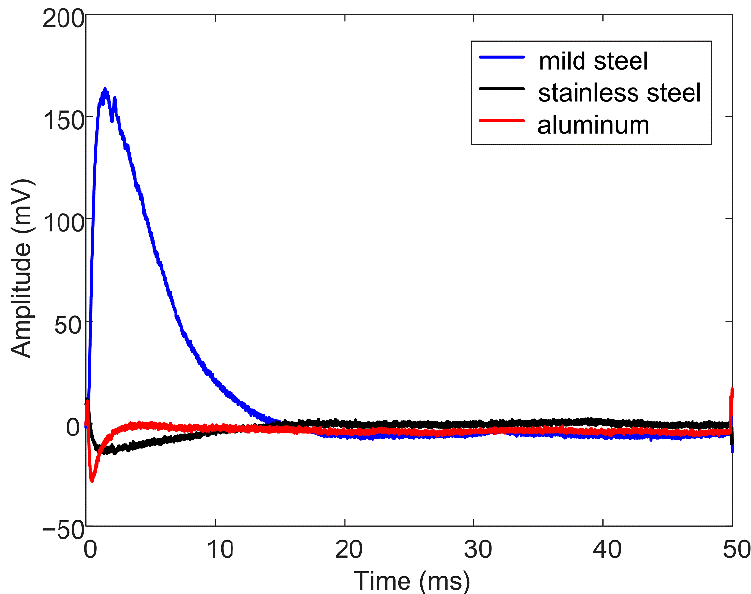
Figure 12. Experimental results for metal mesh made of mild steel, stainless steel, and aluminum, respectively.